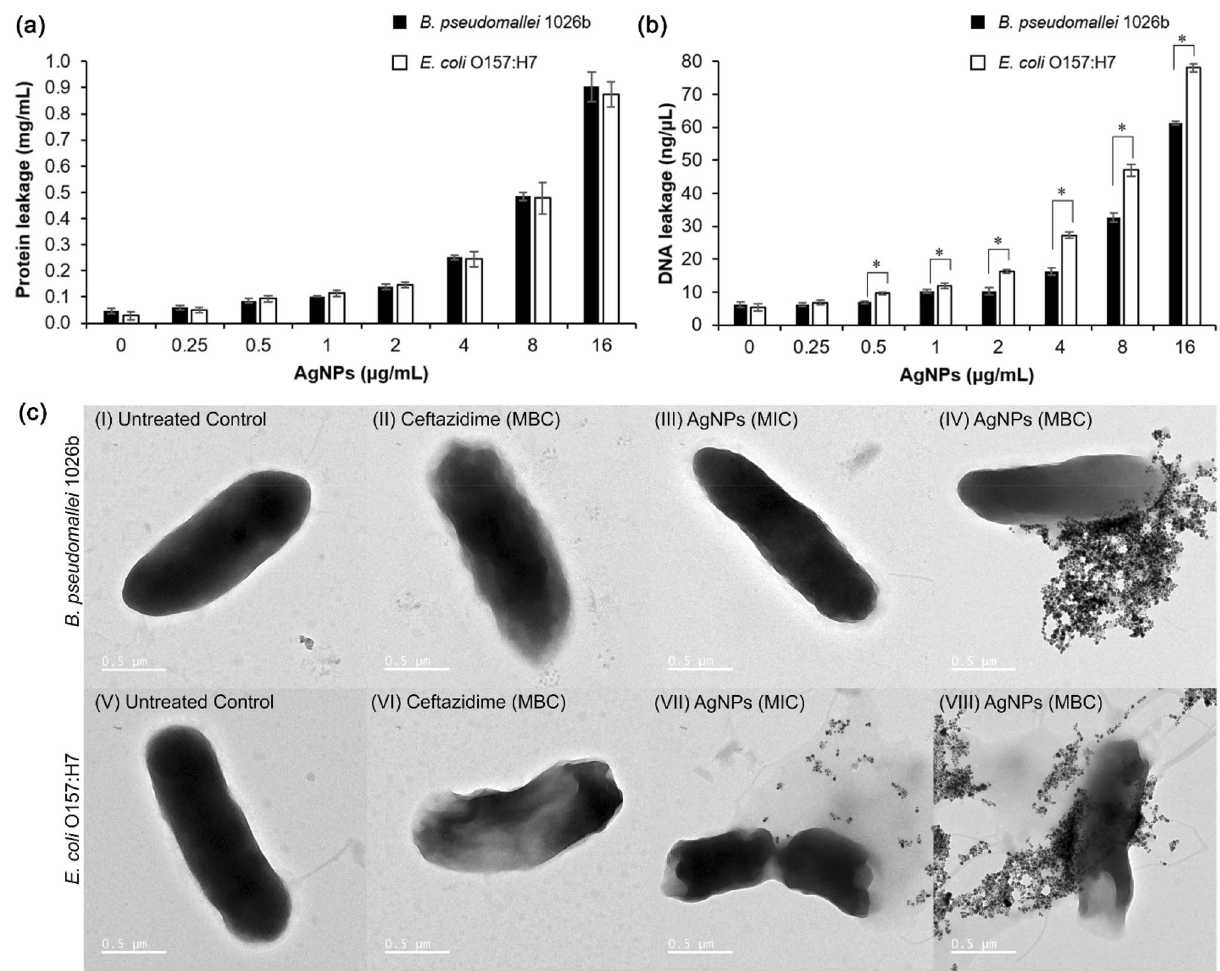
Figure 7. Membrane integrity and morphological change of bacteria in the presence of andro-AgNPs. Membrane integrity of B. pseudomallei 1026b and E. coli O157:H7 were evaluated by protein ( a ) and DNA leakage ( b ). The bacteria were incubated with various concentration of AgNPs for 1 h. Supernatant of protein and DNA leakage were kept after centrifugation and quantified by absorption spectroscopy at 280 nm and 260 nm, respectively. An asterisk (*) indicates significant difference in DNA leakage between B. pseudomallei 1026b and E. coli O157:H7 ( p < 0.05) samples. Data represents the mean ± standard error from two independent experiments performed in triplicate (n = 6). ( c ) TEM image of cell morphological change of B. pseudomallei 1026b (I-IV) and E. coli O157:H7 (V-VIII). The bacteria were treated with ceftazidime at the concentration of MBC or AgNPs at MIC and MBC for 1 h and then observed by TEM. The same cells in Mueller Hinton broth served as a negative studies confirm that andro-AgNPs interact with bacterial cell surfaces and cause membrane damage and leakage of cytoplasmic components. Model of the proposed mode of action of andro‑AgNPs against B. pseudomallei. The proposed mode of action of andro-AgNPs against B. pseudomallei evidenced from the studies herein is shown schemati- cally in Fig. 8. Once andro-AgNPs are incubated with bacterial cells, surface binding occurs, neutralizing the membrane charge within 5 min (Fig. 4). This implies effective adhesion and accumulation of andro-AgNPs on the cell surface (confirmed by Fig. 7c), with consequent structural changes. The andro-AgNPs also release Ag + in large fractions after 5 min of incubation and continue this release for 3 h (Fig. 5). Ag + likely also adhere to the cell wall and cytoplasmic membrane, enhancing the permeability of the cytoplasmic membrane and the destruction of the bacterial envelope. Both andro-AgNPs and Ag + could induce the observed generation of intracellular ROS that promoted biomolecule (protein, DNA, lipid etc.) damage and further disruption of the bacterial membrane (Fig. 6). Eventually, the bacteria exhibit membrane leakage and releasing of cytoplasmic components leading to death (Fig. 7).